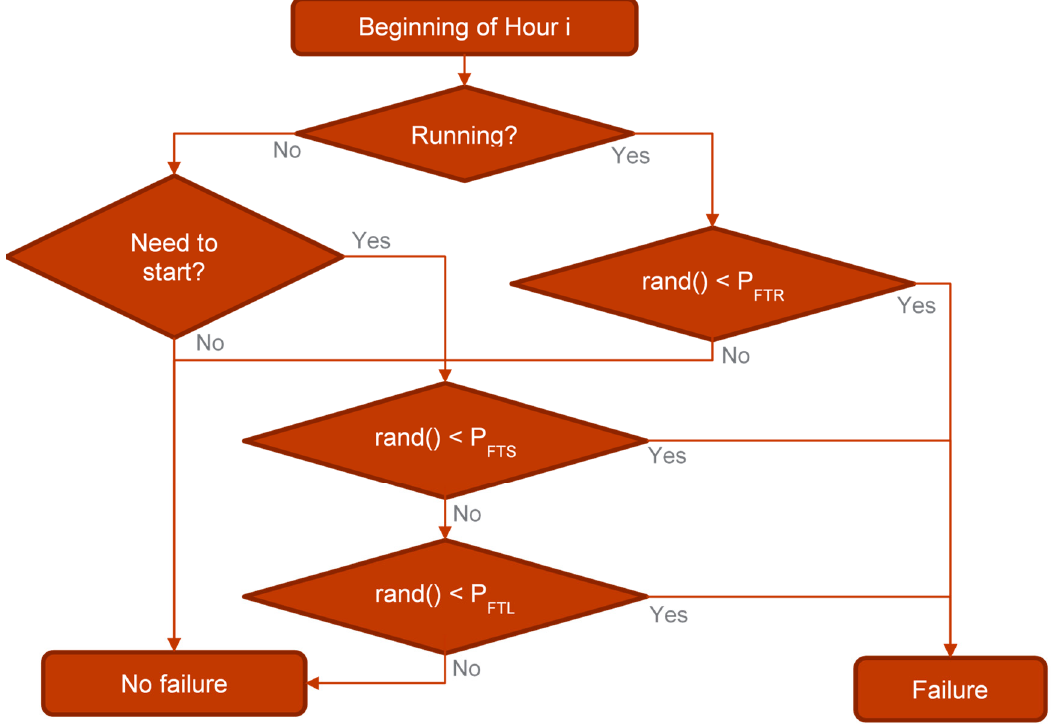
Figure 12. Flowchart to simulate distributed generator (DG) failure in each hour.